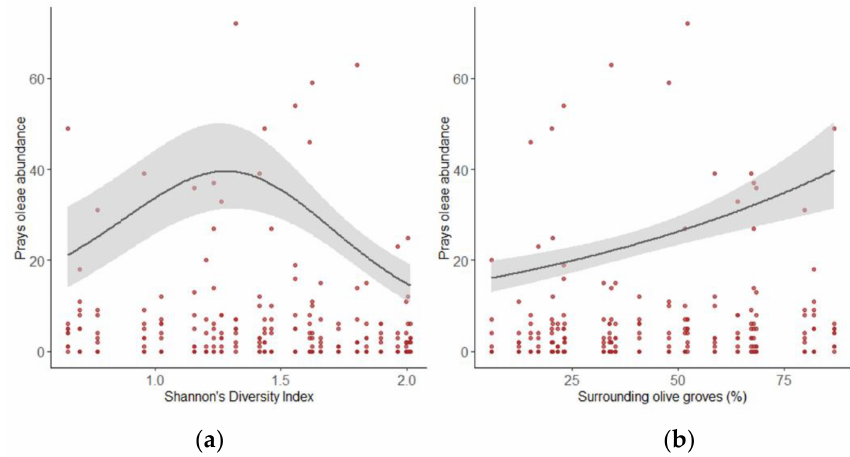
Figure 3. ( a ) Effects of surrounding diversity measured through Shannon’s diversity index on P. oleae abundance. Black solid line represents the abundance of P. oleae . Shaded areas represent the interval of confident at 95%; ( b ) Effects of surrounding olive groves percentages on P. oleae abundance. Black solid line represents the abundance of P. oleae . Shaded areas represent the interval of confident at 95%.